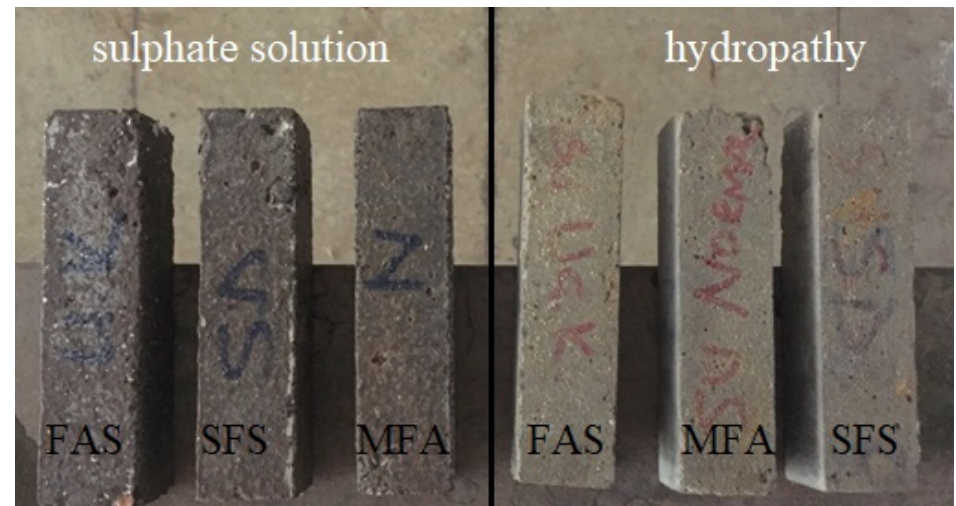
Figure 10. Plain concrete (MFA), silica fume (SFS) and fly ash (FAS) mineral additives substituted bar samples with curing conditions in hydropath and sulphate solution.